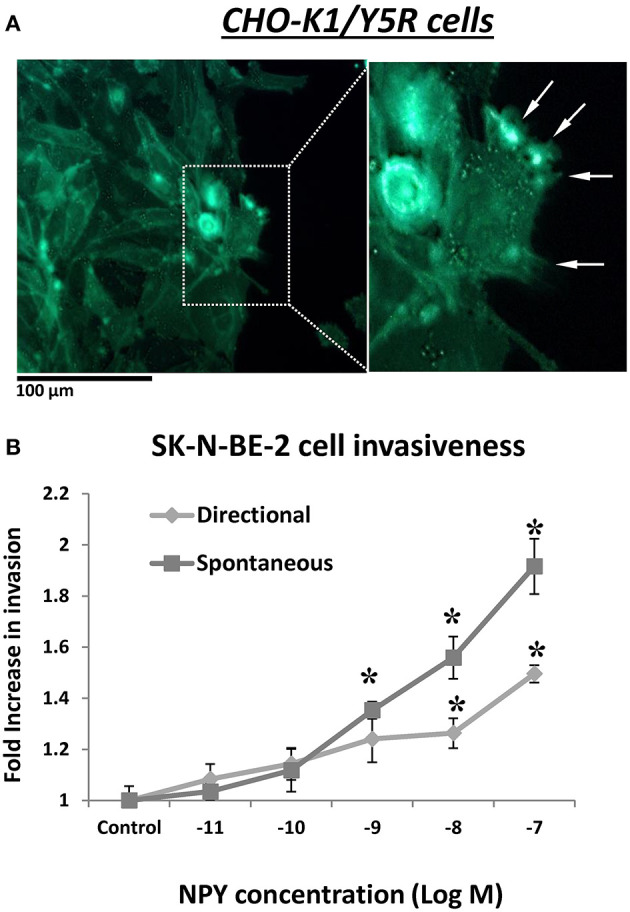
NPY/Y5R axis is involved in cell invasiveness. (A) Representative microscopic image of CHO-K1/Y5R cells invading Matrigel. White arrows indicate invadopodia. (B) NPY-induced SK-N-BE(2) cell invasiveness measured in a Matrigel-coated Transwell plate. The cells were subjected to NPY (10−11-10−7 M) for 22 h in the lower chamber of the Transwell plate (directional invasiveness) or both upper and lower chambers (spontaneous invasiveness). *p < 0.05 by one-way ANOVA followed by Dunnett's test; mean ± SEM, n = 4.